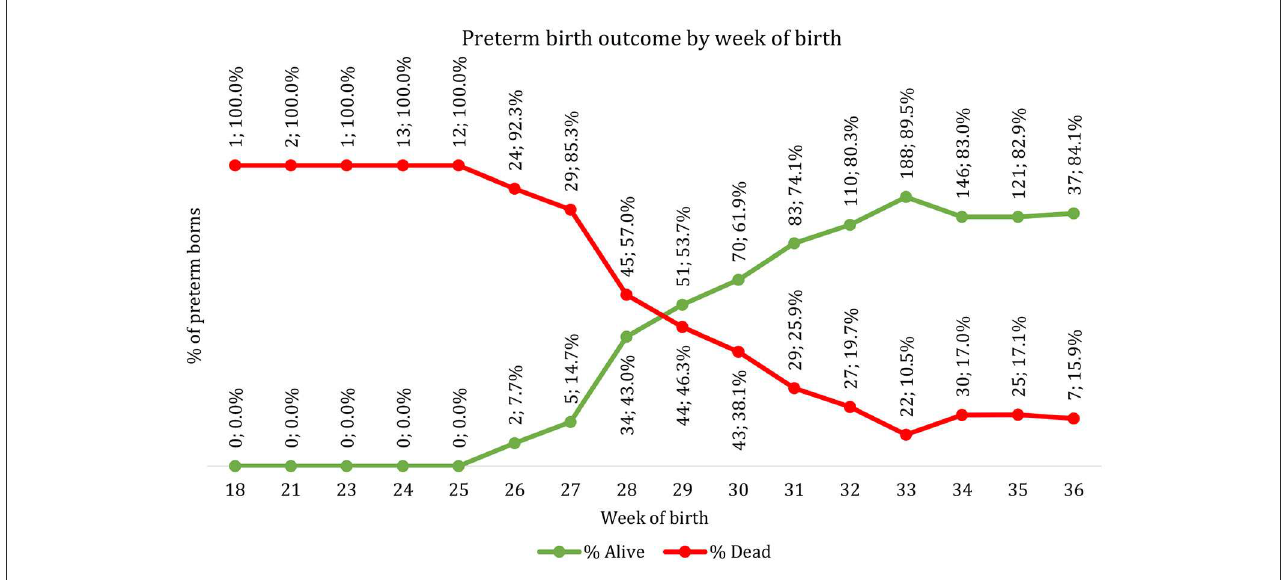
FIGURE2 Preterm outcome by the week of